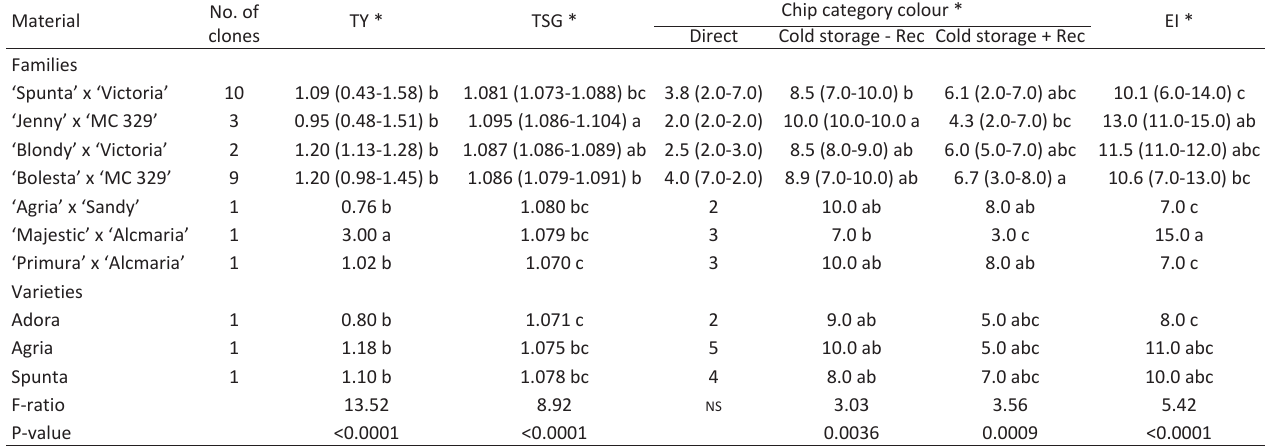
* Means comparison using tukey’s test. levels not connected by the same letter are significantly different (p<0.05). nS indicates not statistically significant table 3 - Means, ranges and comparisons between clones and control varieties (Spunta, Adora, Agria) obtained evaluating tuber yield (tY), tuber specific gravity (tSG), chipping ability (direct, after cold storage, ± reconditioning, rec) and the evaluation index (ei)